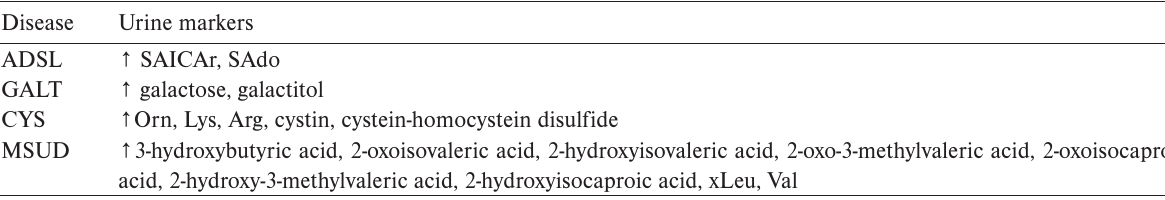
Table 1. Summary of studied defects with their urine markers.